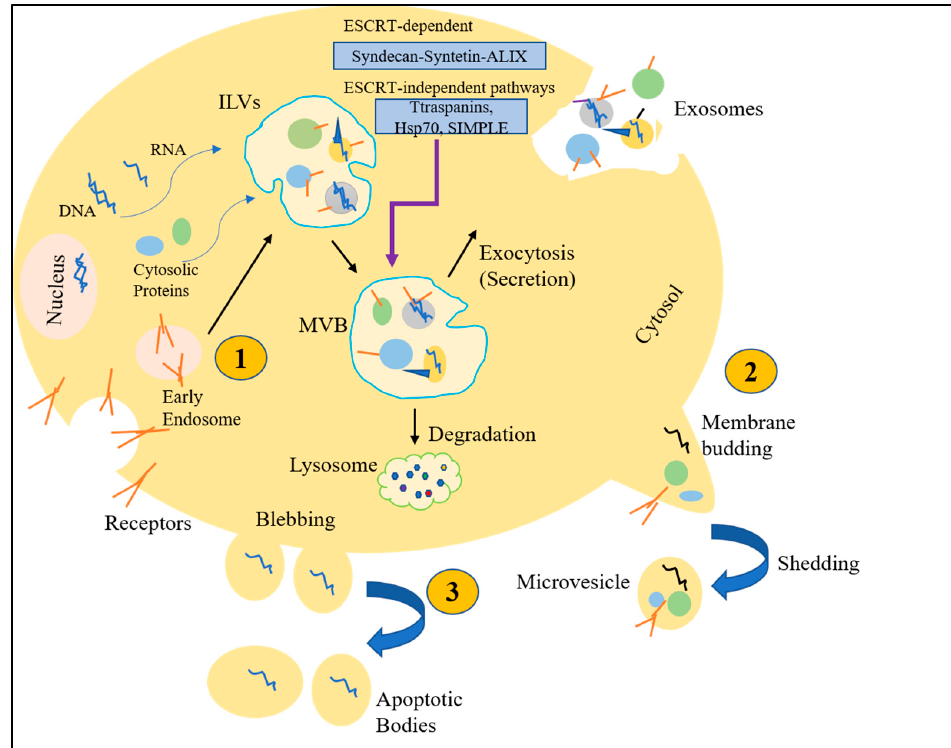
Figure 3. Extracellular vesicles biogenesis and secretion. A eukaryotic cell is schematically represented creating and secreting EVs. (1) Biogenesis of exosomes starts as ILVs following budding into early endosomes. However, ESCRT-dependent or ESCRT-independent MVBs form and undergo one of two fates; degradation through fusion with lysosomes or release of exosomes through fusion with the plasma membrane. (2) Outward budding and fission of the plasma membrane leads to shedding of micro vesicles to extracellular space regulated by phospholipid redistribution and cytoskeletal protein contraction. (3) Upon programmed cell death, apoptotic bodies are formed by actin-myosin mediated membrane blebbing and known as the largest EVs.